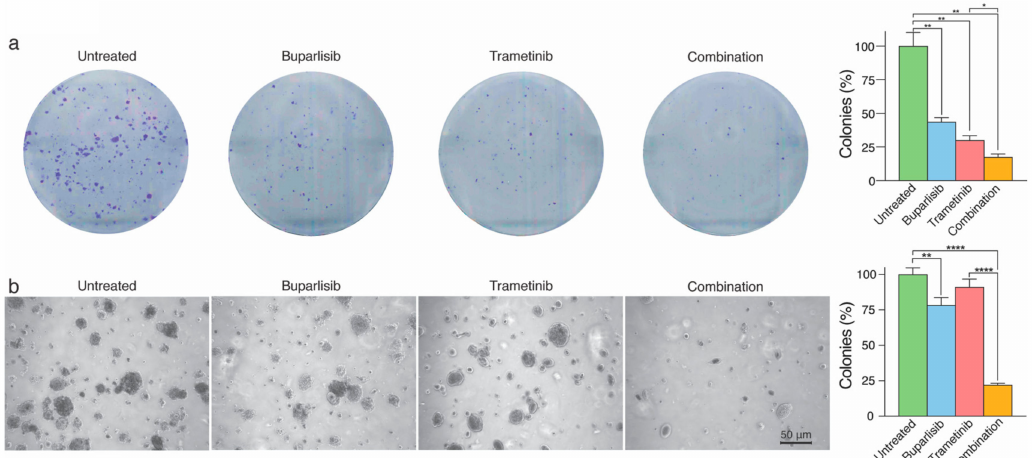
Figure 3. In vitro colony formation of H1 cells after pre-treatment with buparlisib and trametinib. ( a ) representative images of H1 cells pre-treated with 10 µ M buparlisib, 10 µ M trametinib or a combination (5 µ M buparlisib + 5 µ M trametinib) grown as colonies. The colony formation was scored and quantified as seen in the graph to the right; ( b ) representative images of H1 cells pre-treated with corresponding drug concentrations seeded into low melting point agarose and incubated for 21 days. Scale bar = 50 µ M. The percentage area covered by the spheroids within the total visual field was quantified as seen to the right. The experiments were performed in triplicate ( n = 4 images). Abbreviations: *: p < 0.05, **: p < 0.01 and ****: p <